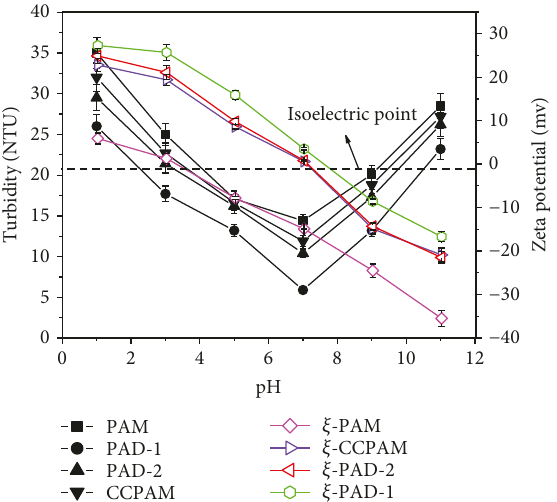
Figure 13: E ff ect of the pH on (a) turbidity removal and zeta